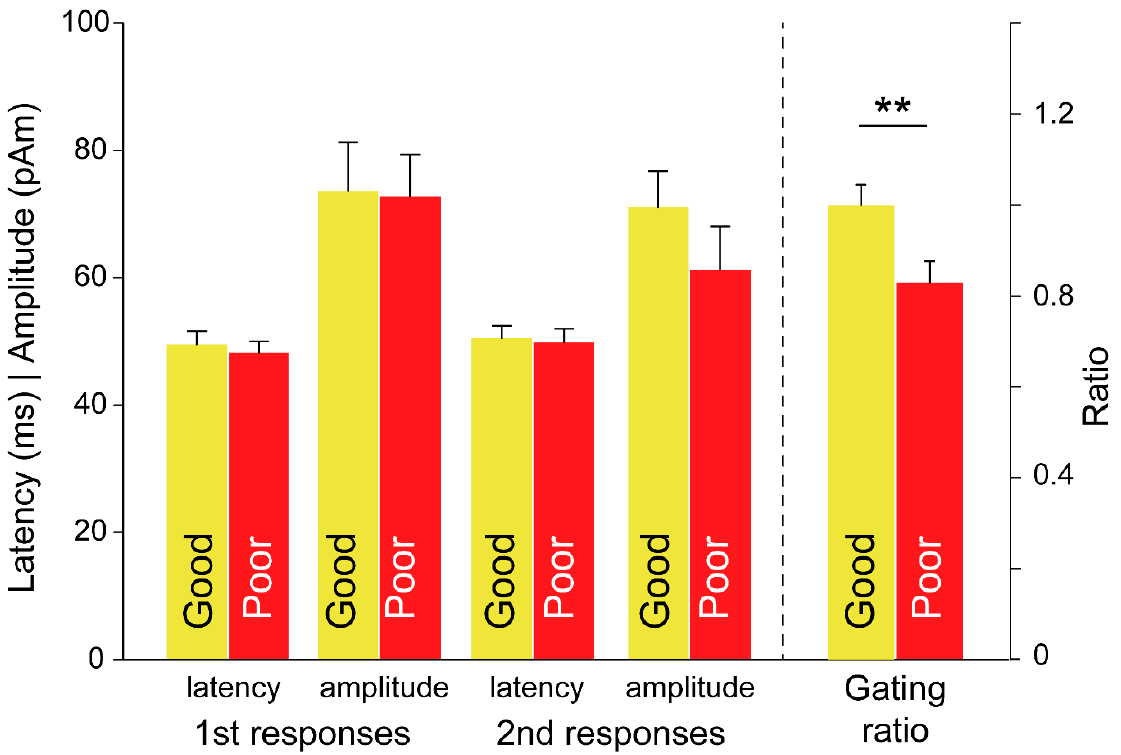
Figure 4. Differences in somatosensory amplitude and latency responses, and in gating ratio in patients with chronic migraine for the effect of treatment outcomes. **, p < 0.01.